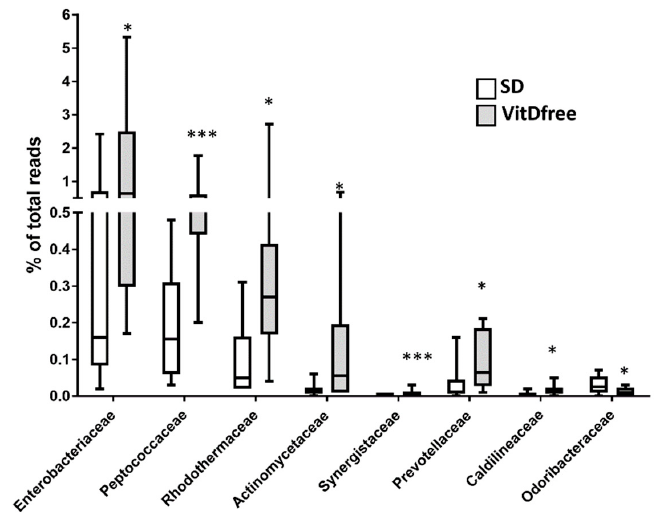
Figure 5. Effects of vitamin D-free diet on the relative family abundance. The most significant changes at the family level are shown as a percent of total reads and represented in a box and whiskers plot for the standard diet (SD, n = 10) and vitamin D-free diet group ( n = 10). * p < 0.05 and *** p < 0.001 vs. SD, student’s t-test.